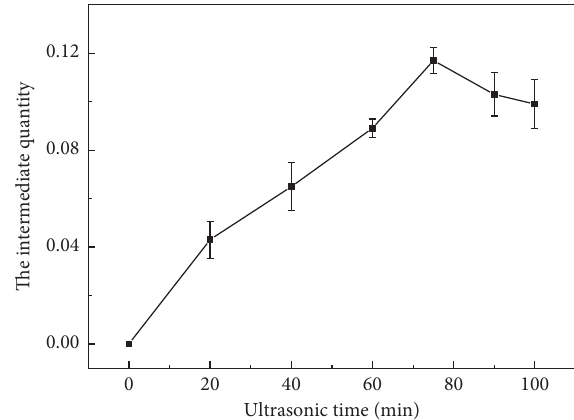
Figure 7: The effect of ultrasonic time on browning intensity.